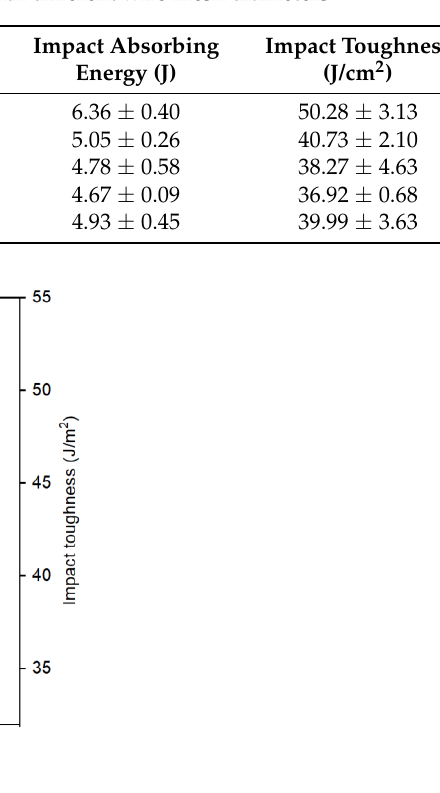
Figure 4. Variation trend of the impact properties of PWMCPPs with different wire mesh diameters.